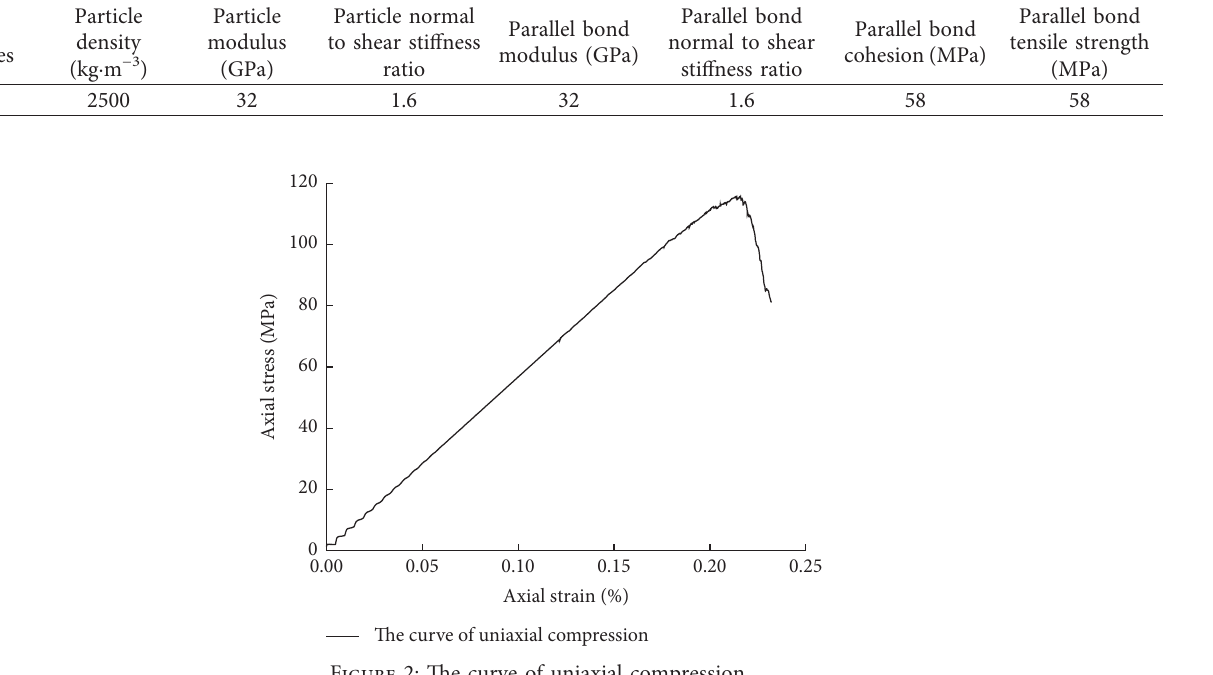
Table 1: The calibrated micro-mechanical parameters of marble.